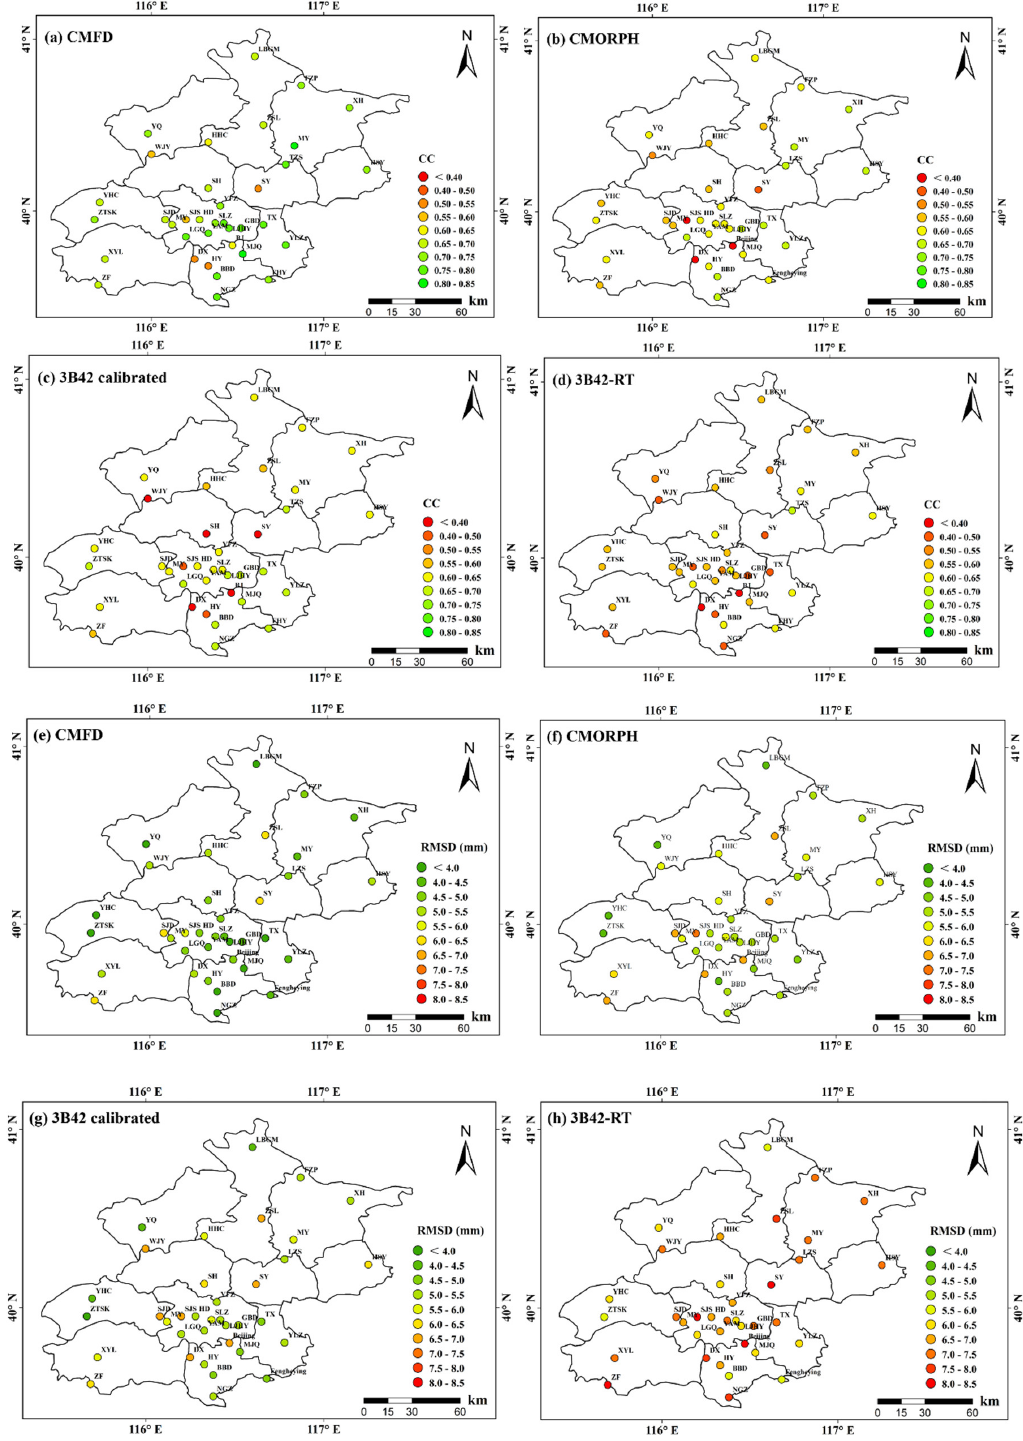
Figure 3. The spatial distributions of CC from ( a ) CMFD, ( b ) CMORPH, ( c ) 3B42 calibrated, ( d ) 3B42-RT, and RMSD (mm) from ( e ) CMFD, ( f ) CMORPH, ( g ) 3B42 calibrated, ( h ) 3B42-RT at each station for the four precipitation products evaluated in this study. Table 4. Categorical metrics for detection of daily precipitation at 36 stations in Beijing using four satellite-derived precipitation products. POD FAR CSI